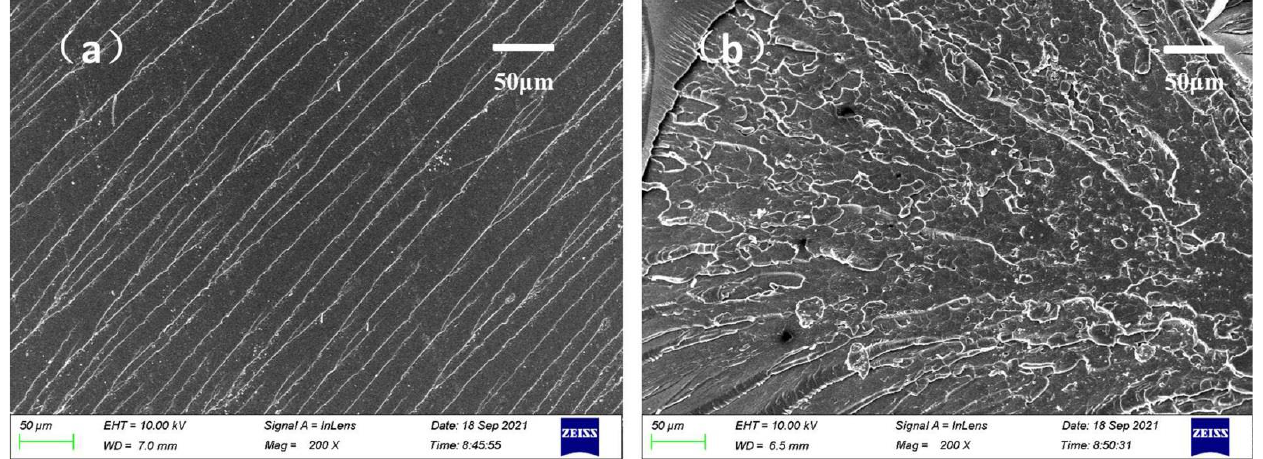
Figure 8. SEM images of fracture surface for UPR before ( a ) and after ( b ) HBP-1-600